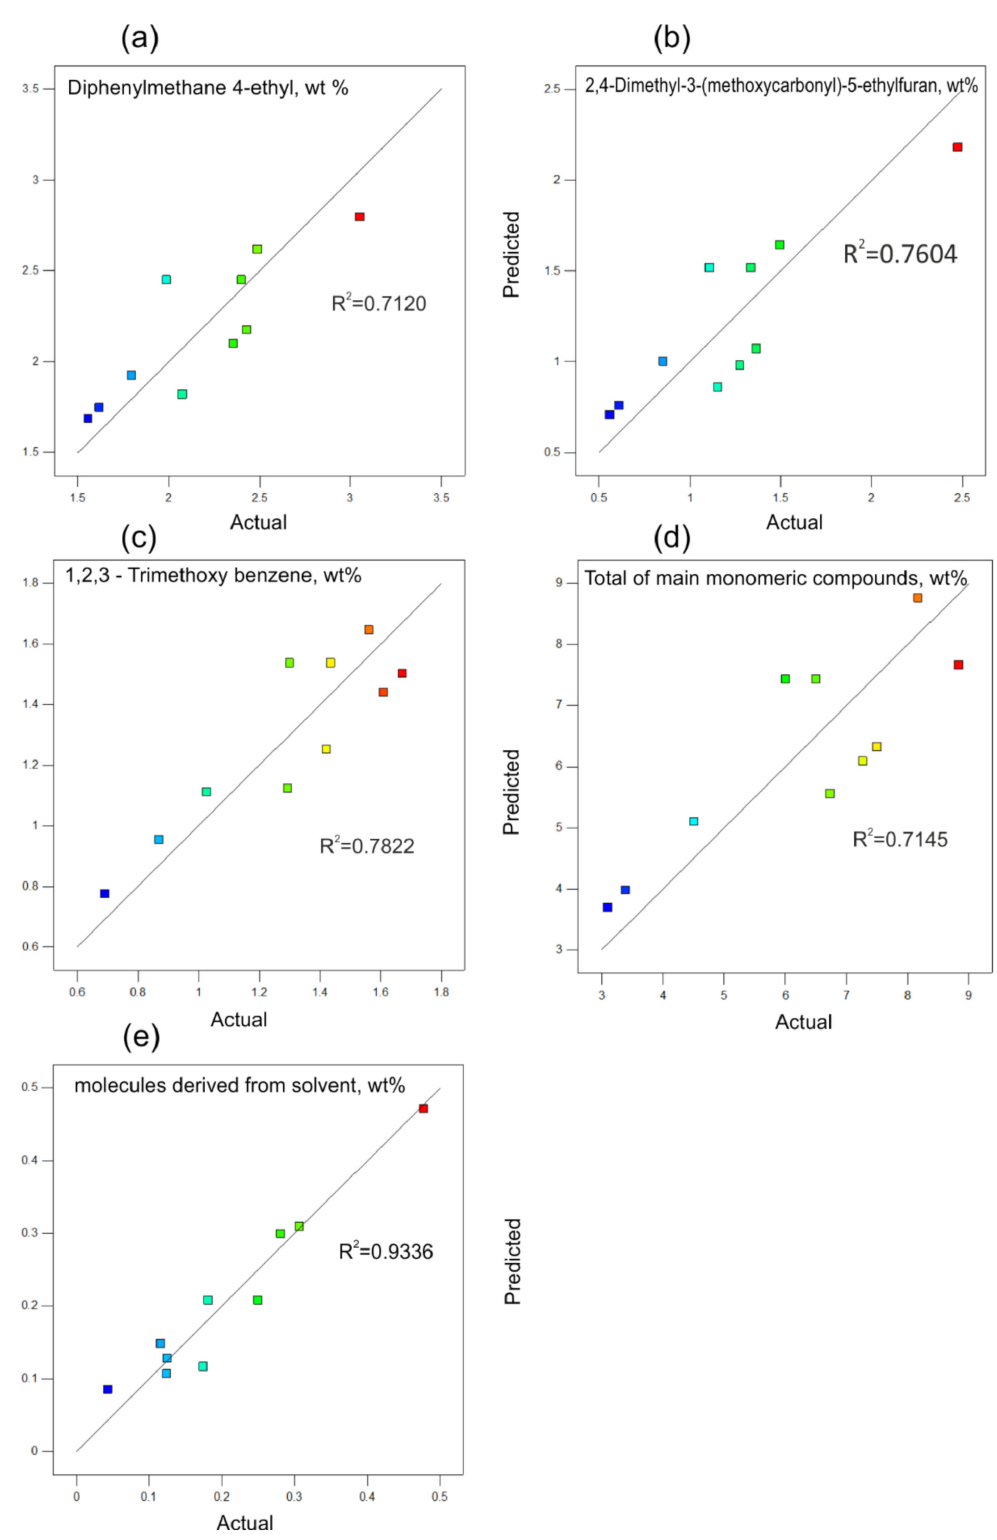
Figure 4. Predicted molecule production vs experimental values. ( a ) Response 1; ( b ) Response 2; ( c ) Response 3; ( d ) Re- sponse 4; ( e ) Response 5 (see Table